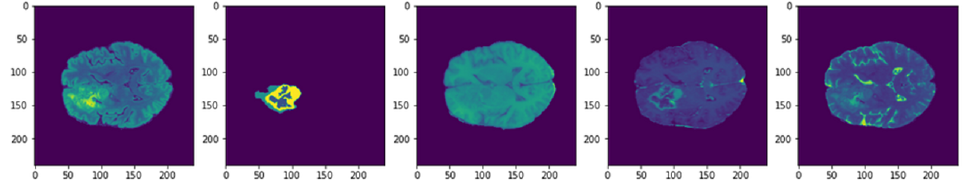
Figure 4. Example of dataset